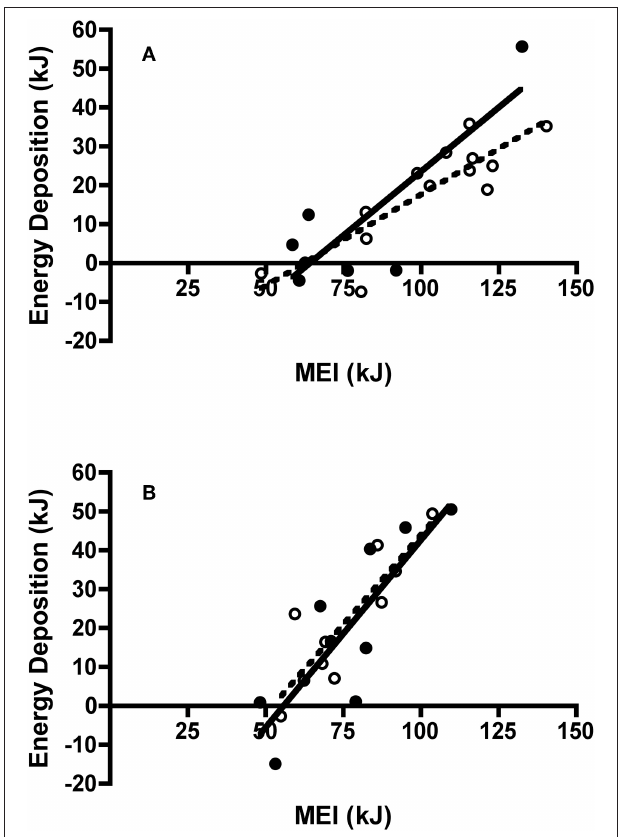
FIGURE 8 | Effect of metabolizable energy intake (MEI) on energy deposition of adult and juvenile (A) Swainson’s thrushes and (B) white-throated sparrows during the last day of a 2-day total collection mass balance feeding trial. All birds captured at Long Point, ON, Canada during fall 2011 migration stopover. Filled circles and solid lines represent adults: thrushes energy deposition = − 42.15 ( ± 16.40) + 0.658 ( ± 0.200) * MEI, r 2 = 0.68; sparrows energy deposition = − 53.91 ( ± 19.24) + 0.965 ( ± 0.244) * MEI, r 2 = 0.69. Unfilled circles and dashed lines represent juveniles: thrushes energy deposition = − 29.36 ( ± 9.23) + 0.471 ( ± 0.088) * MEI, r 2 = 0.72; sparrows energy deposition = − 48.01 ( ± 14.16) + 0.919 ( ± 0.184) * MEI, r 2 =